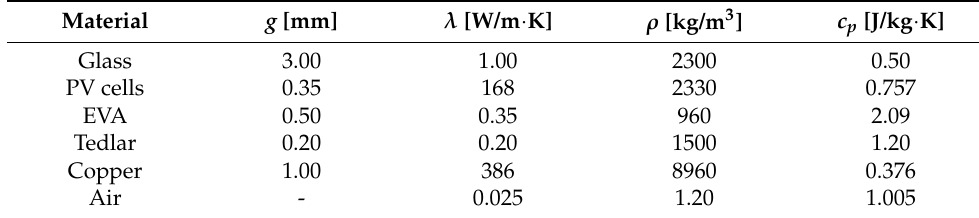
Table 3. Thermophysical properties of the materials